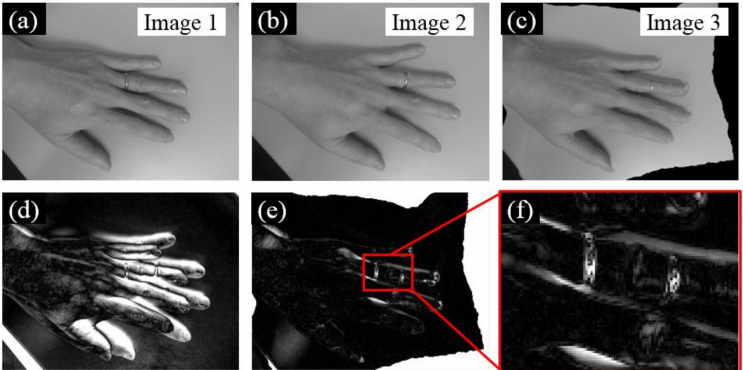
Figure 4. Demonstration of intensity-based image registration through an example of two images of the same hand under different poses. ( a , b ) Two input images; after registration, Image 2 is registered as Image 3 as shown in ( c ); ( d ) the intensity comparison between Image 1 and 2; ( e ) the intensity comparison between Image 1 and 3; and ( f ) a detailed look of Figure